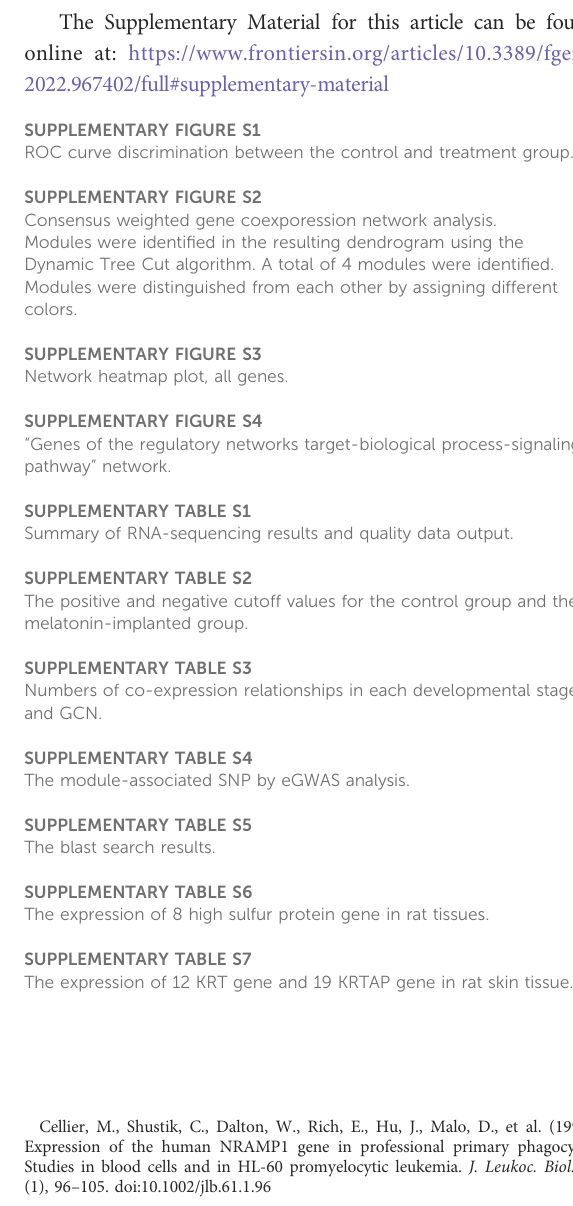
SUPPLEMENTARY FIGURE S1 ROC curve discrimination between the control and treatment group. SUPPLEMENTARY FIGURE S2 Consensus weighted gene coexporession network analysis.